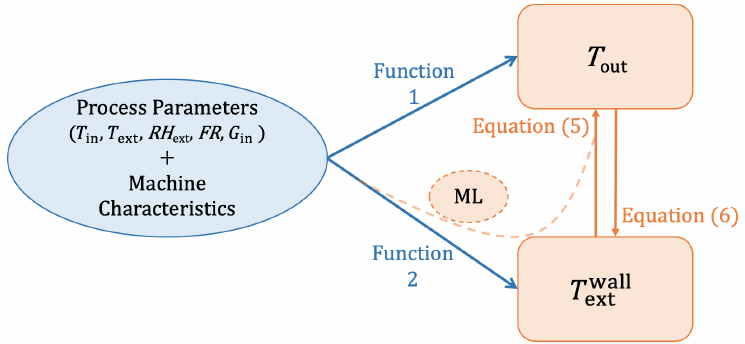
Figure 1. Schematic representation of the resolution approach used and the relationship between variables. The set of process parameters and spray dryer characteristics are shown in the blue oval, while the two experimental outputs linked by Equations (5) and (6) are expressed in the orange boxes. The machine learning (orange dashed line) allows the mimicking of Function 2 to determine T wall and finally, to find, with Equation (5), T out